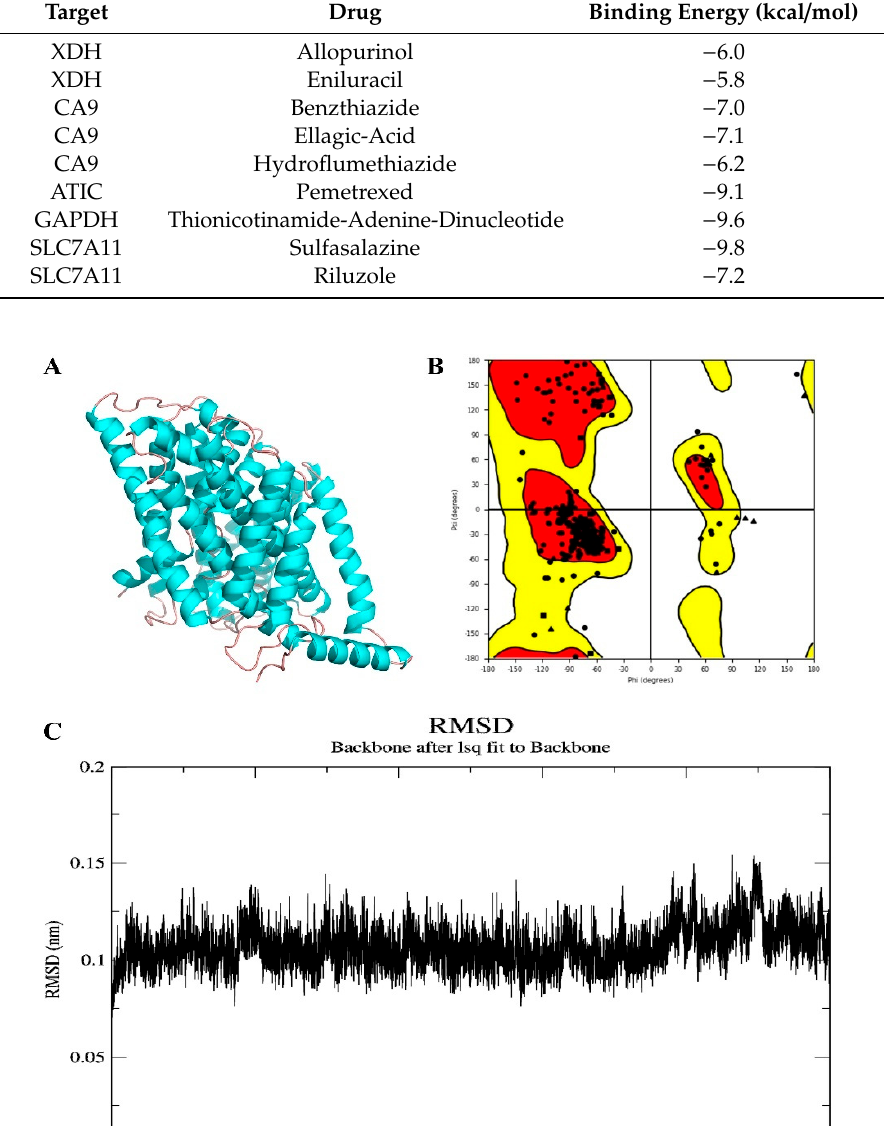
Table 4. Binding Energy for targets with their drugs.